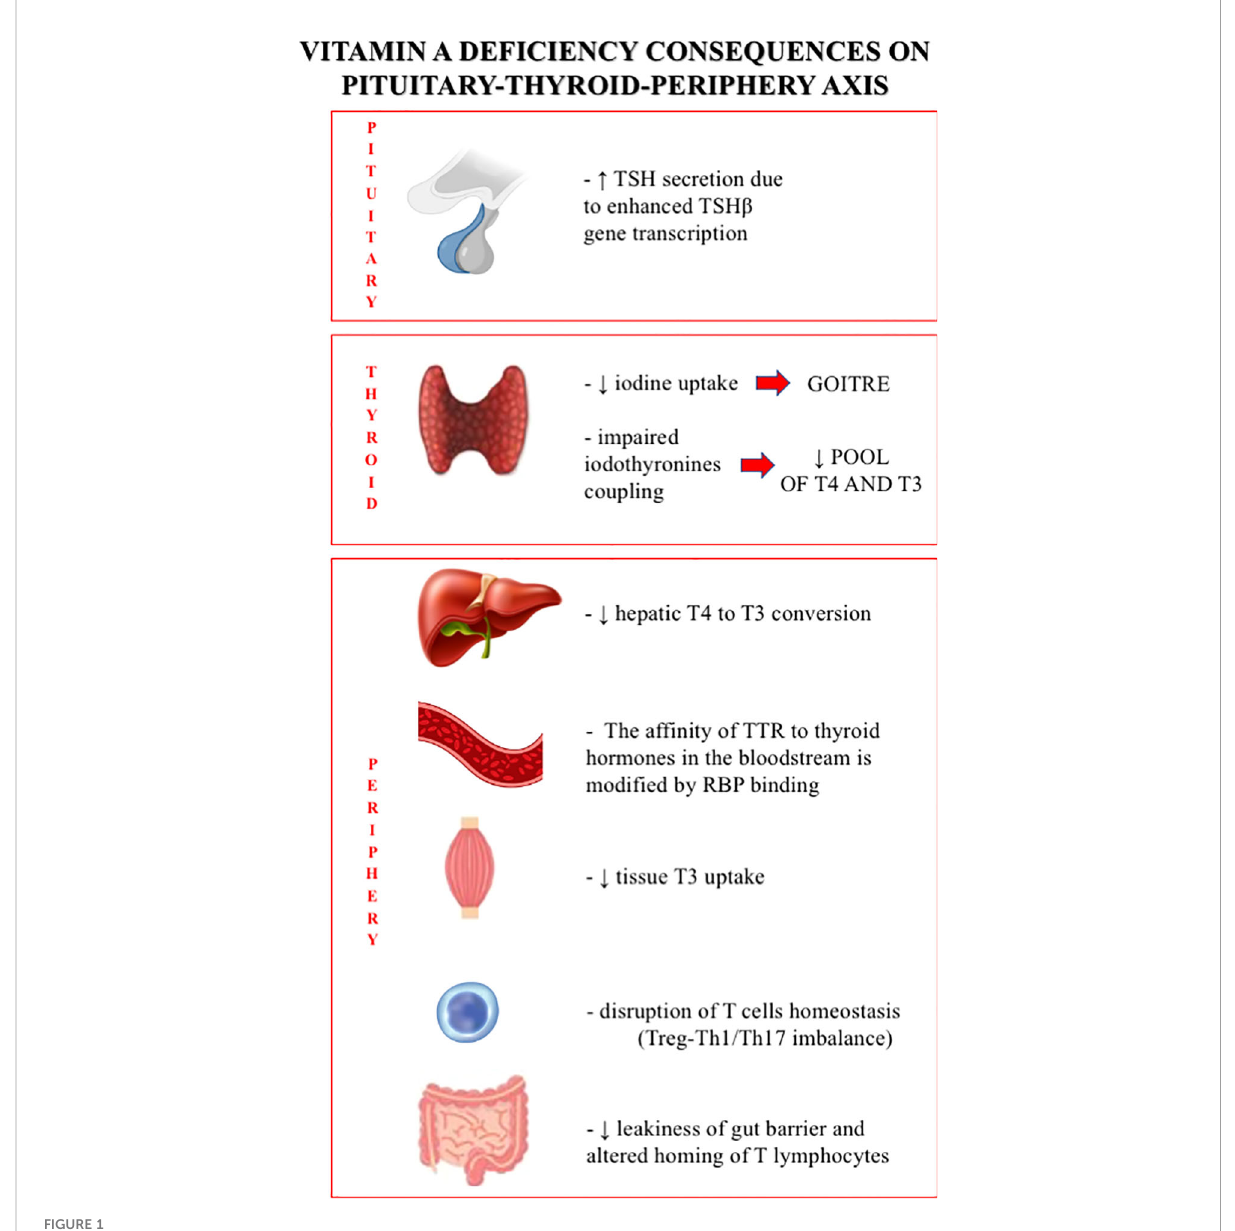
FIGURE 1 Vitamin A de fi ciency consequences on pituitary-thyroid-periphery